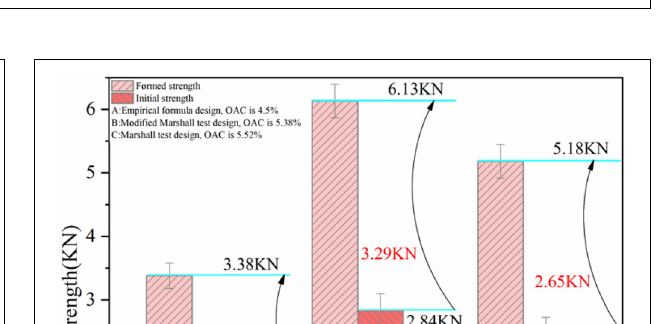
FIGURE 4 | Road performance test flow chart of CPAM.